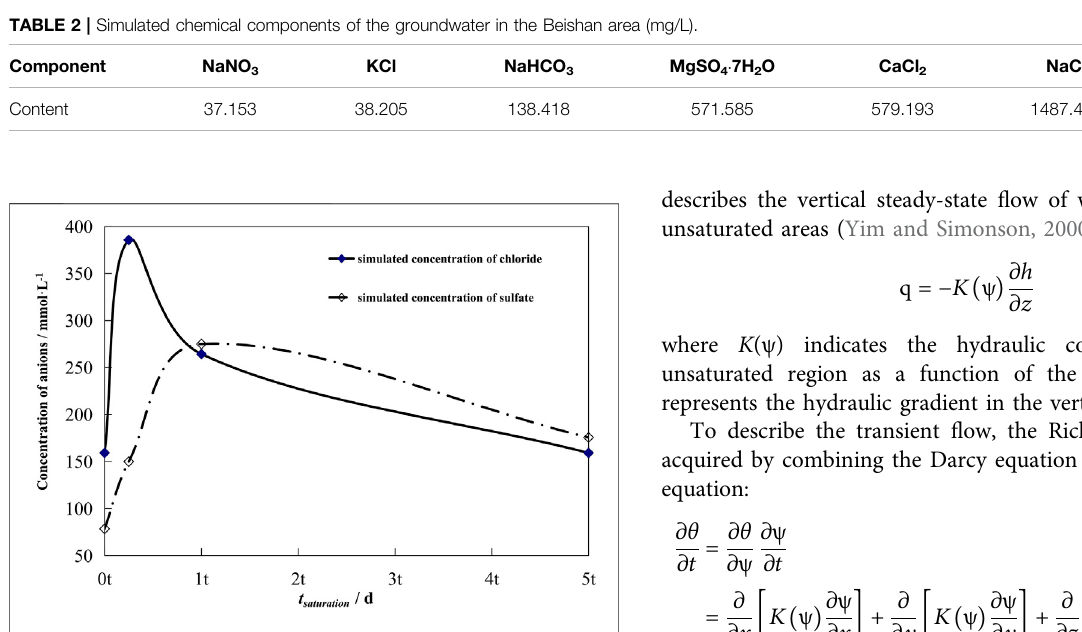
FIGURE4| ConcentrationchangesofCl − andSO 42- intheporewaterof bentonite near the waste container (Seetharam et al.,